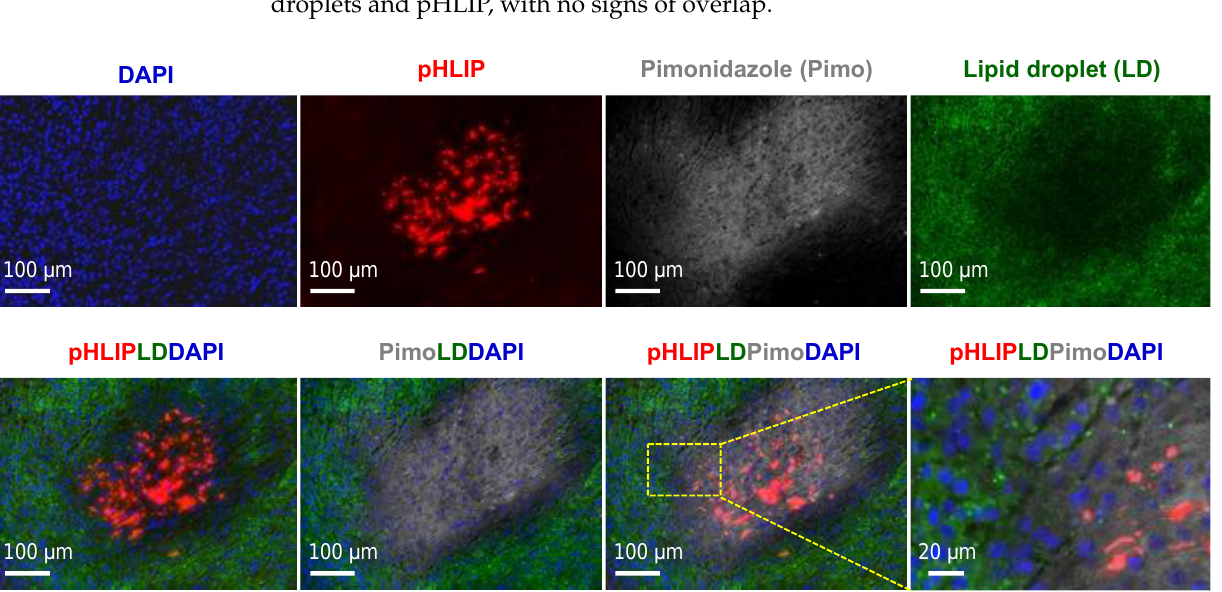
Figure 7. Spatial relationship between the intratumoral distribution (ITD) of pHLIP and macrophages. pHLIP distribution (AF546-pHLIP, red), CD11b-stained macrophages (green), and DAPI-stained nuclei (blue) were examined at the same sites of the same tumor sections. Shown here are images acquired from a representative high pHLIP-accumulated region in a U87MG tumor section. The red/green overlapping (yellow) is not indicated. An enlarged view of the dotted rectangle clearly shows that pHLIPs and macrophages (CD11b-positive cells) were not overlapping.